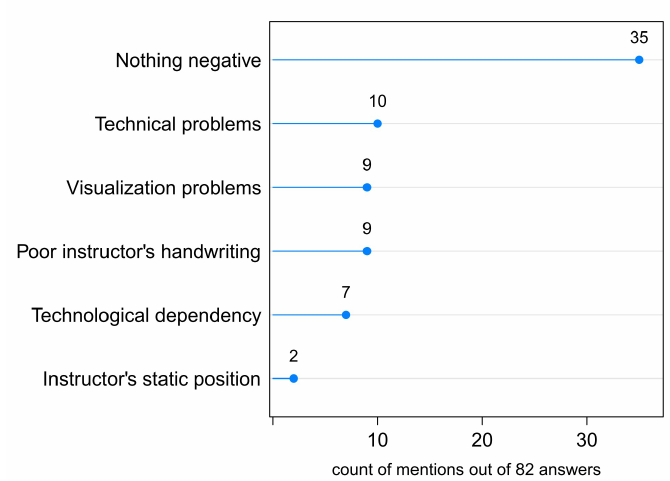
Figure 5. Queston 4 negatve aspects of graphics tablet categorized in six main